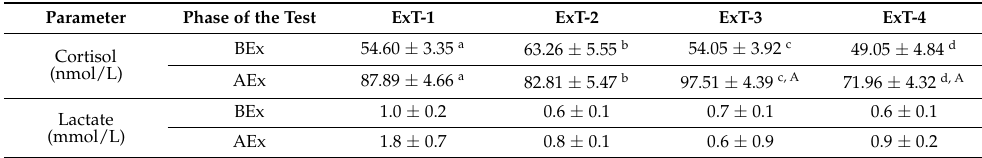
Table 6. Serum cortisol and blood lactate concentrations in Lipizzan fillies before and after exercise (BEx and AEx) in tests 1 to 4 (ExT-1 to ExT-4). Parameter Phase of the Test ExT-1 ExT-2 BEx Cortisol (nmol/L)